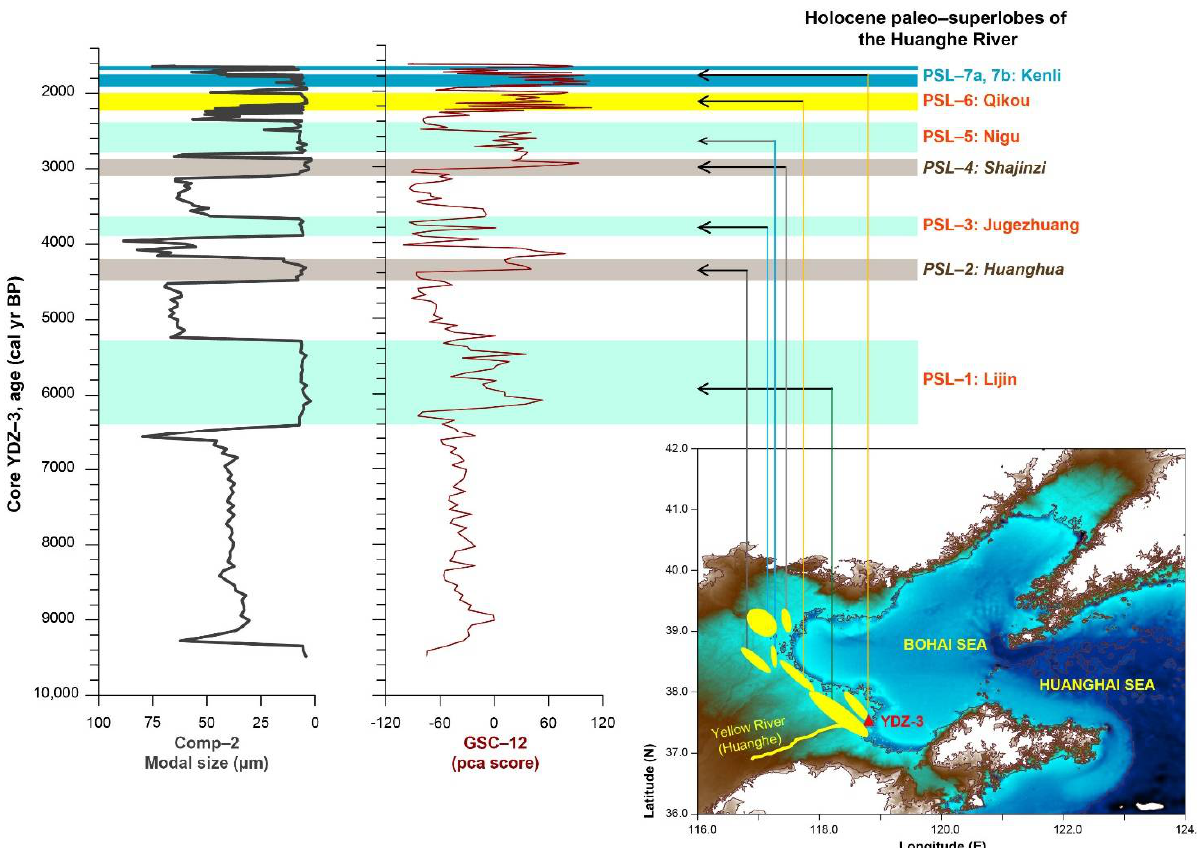
Figure 5. Correlating YDZ–3 comp–2 modal-size record to paleo-superlobe shifts of the Huanghe River and deriving forces of Holocene dynamics on millennial timescales. Seven PSLs (PSL–1 to –7) were labeled as in color bars, and two of them (PSL–2, PSL–4) were missed in the GSC–12 record [8].